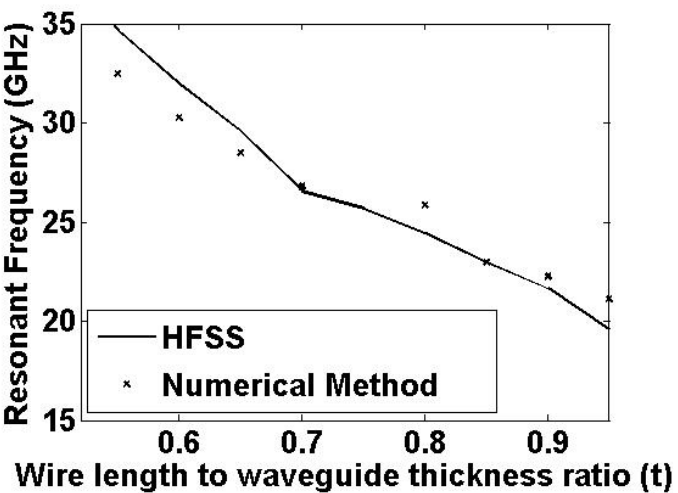
Figure 10. Plot of the first two principal components, which contributed more than 70% of the